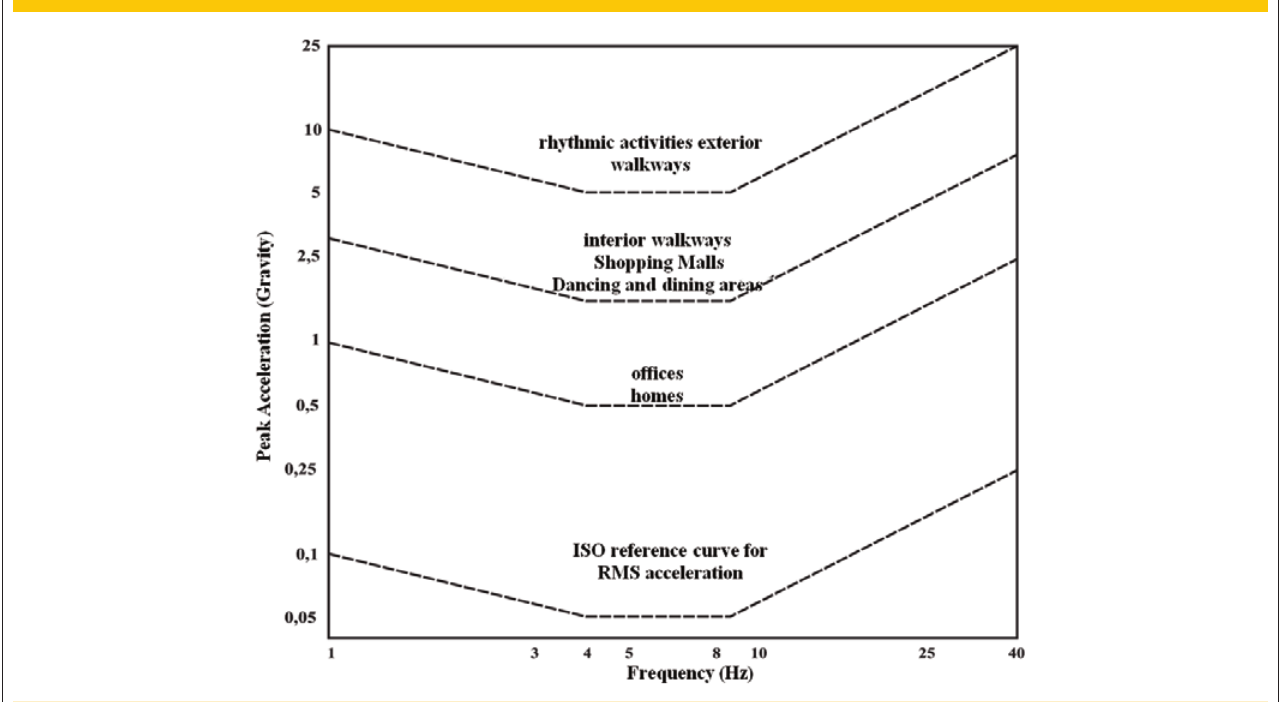
Figure 3.2 – Peak acceleration for environmental comfort due to vibrations related to human